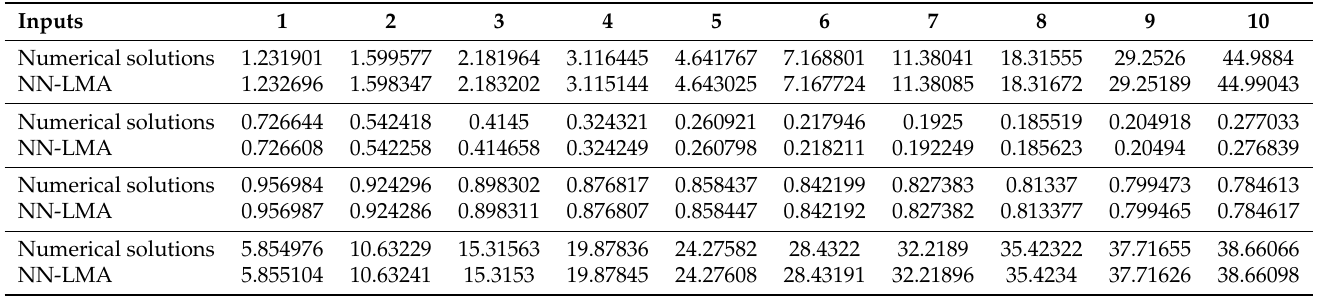
Table 8. Comparative analysis of numerical solutions by NDSolve tool in Mathematica with the solutions obtained from NN-LMA for case